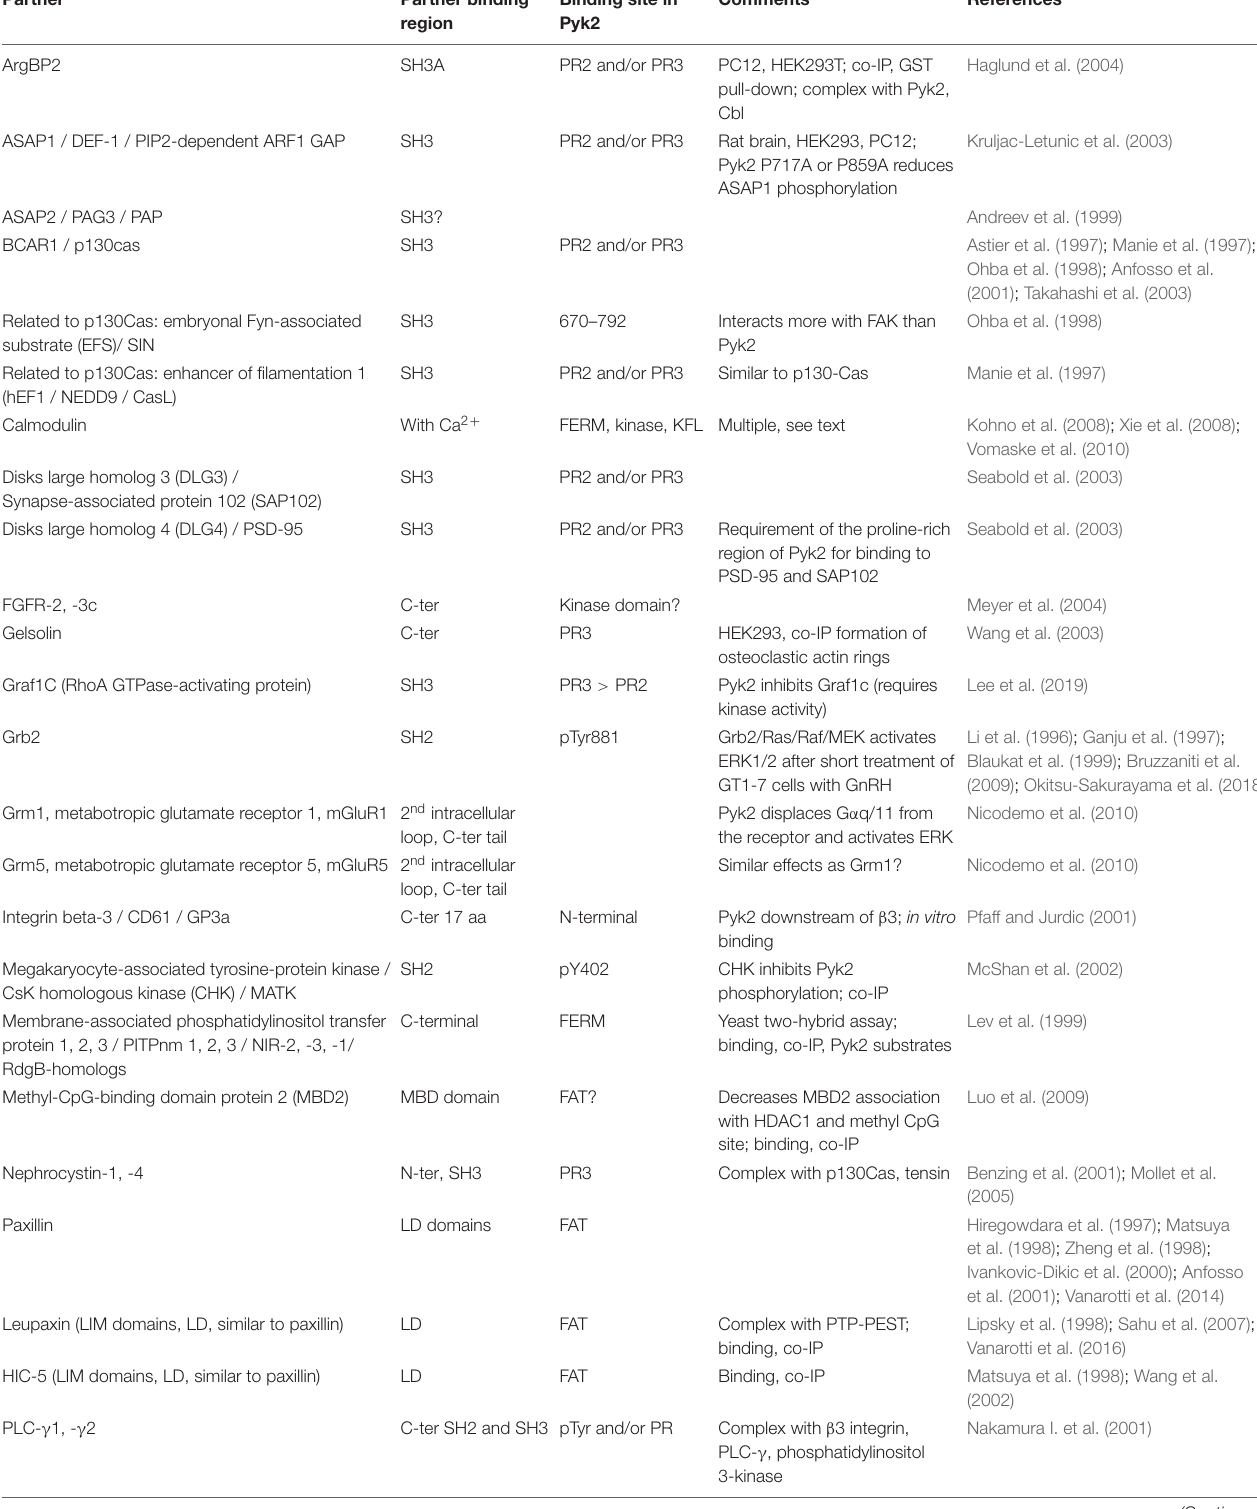
TABLE 1 | Protein partners very likely or shown to interact directly with